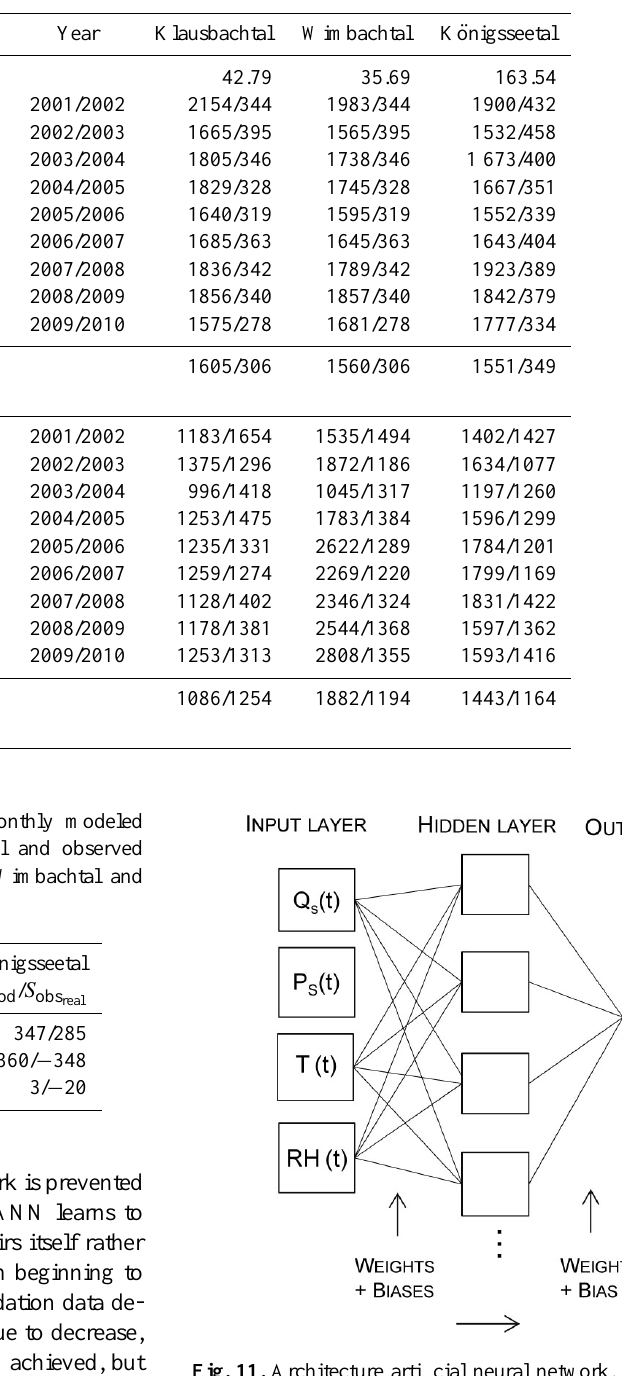
Table 4. Annual sums and mean of modeled precipitation, evapotranspiration, modeled and measured discharge –subbasins Klausbachtal, Wimbachtal and K¨onigsseetal.